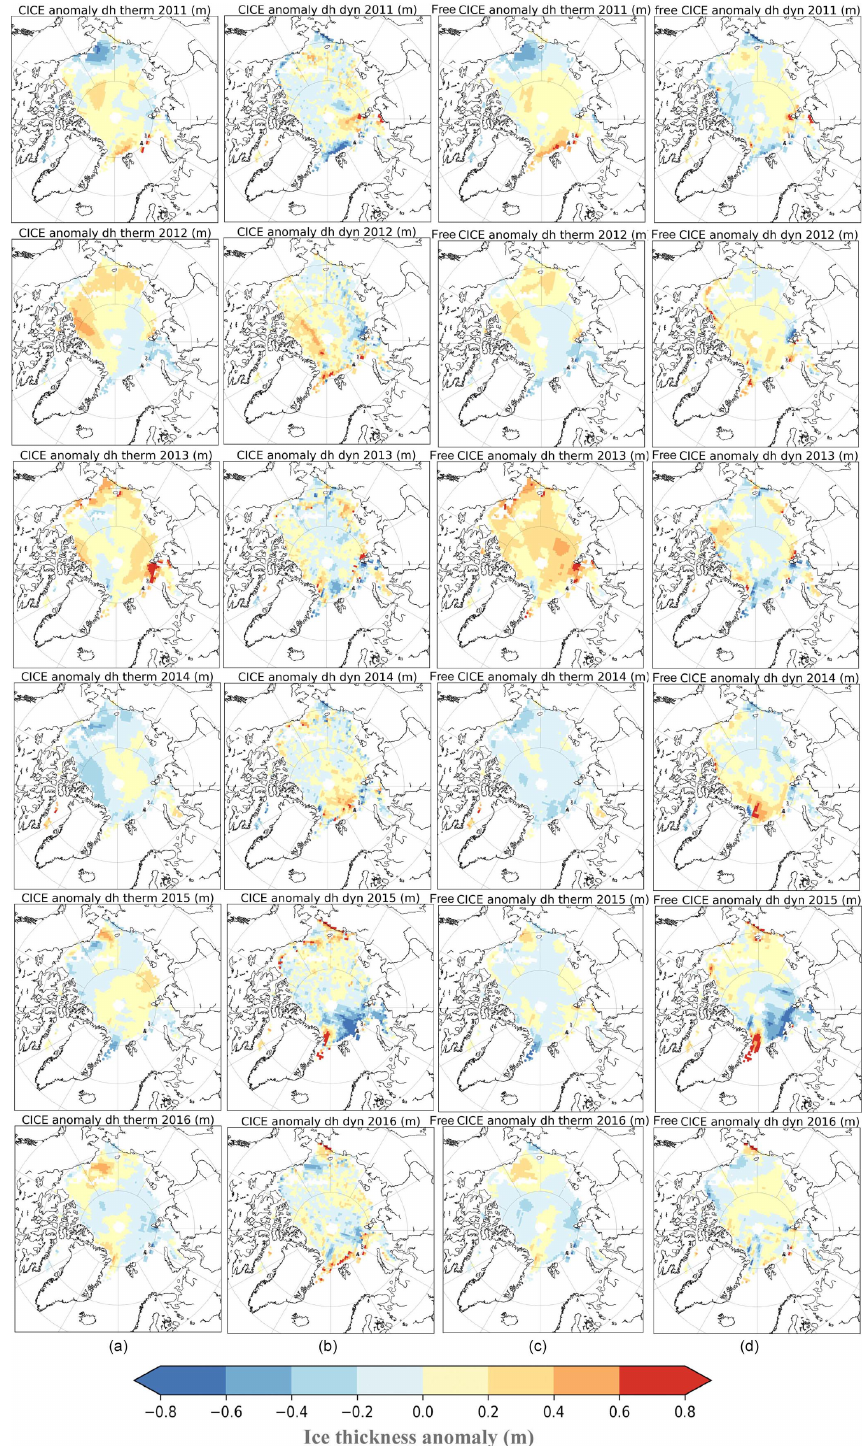
Figure 6. Anomalies of CICE simulated thermodynamic ice growth and dynamical thickness changes in meters relative to the 2011 to 2017 mean from the CICE simulations initialized with November CPOM CryoSat-2 thickness fields (a, b) , and CICE simulations not initialized with CryoSat-2 thickness (c, d) . The year in title reflects the end month over which ice growth occurs (e.g., from November to